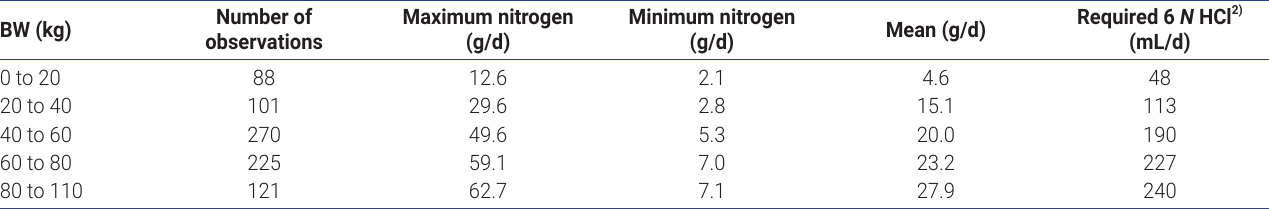
Figure 3. Minimum amounts of 6 N hydrochloric acid (HCl) required for nitrogen preservation for 100 mL pig urine based on urine nitrogen concen- tration (g/100 mL; Exp. 3). The plotted data were based on the x-axis values for pH = 5.12 and urinary nitrogen concentrations presented in Figure 2.